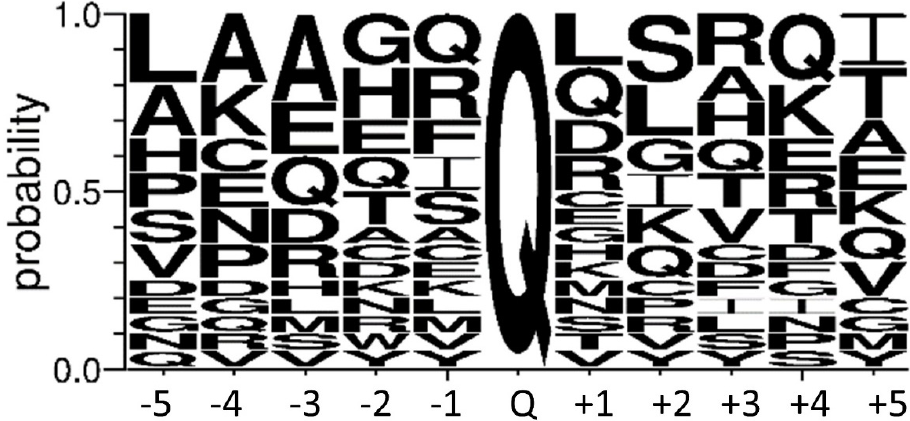
Figure 7. Probability of the amino acid residues between the − 5 and +5 position to the reactive glutamine. Sequence logo created using the 20 most reliable peptide sequences containing the detected BPA-modified Gln (Q) with its surrounding amino acid residues in both directions. The size of the amino acid letter represents the probability of the given amino acids in the substrate recognition region (created by WebLogo 3.8.4. online tool; http://weblogo.threeplusone.com/, accessed on 1 July 2021).